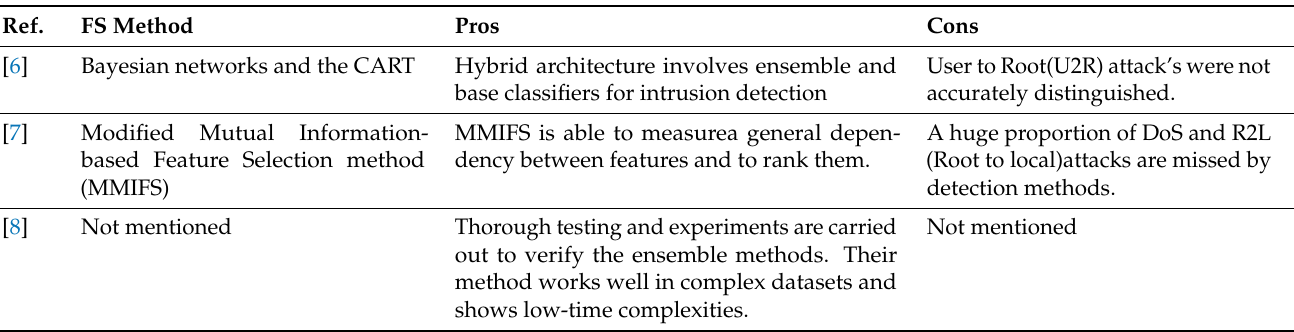
Table 1. Comparative Summary of Existing